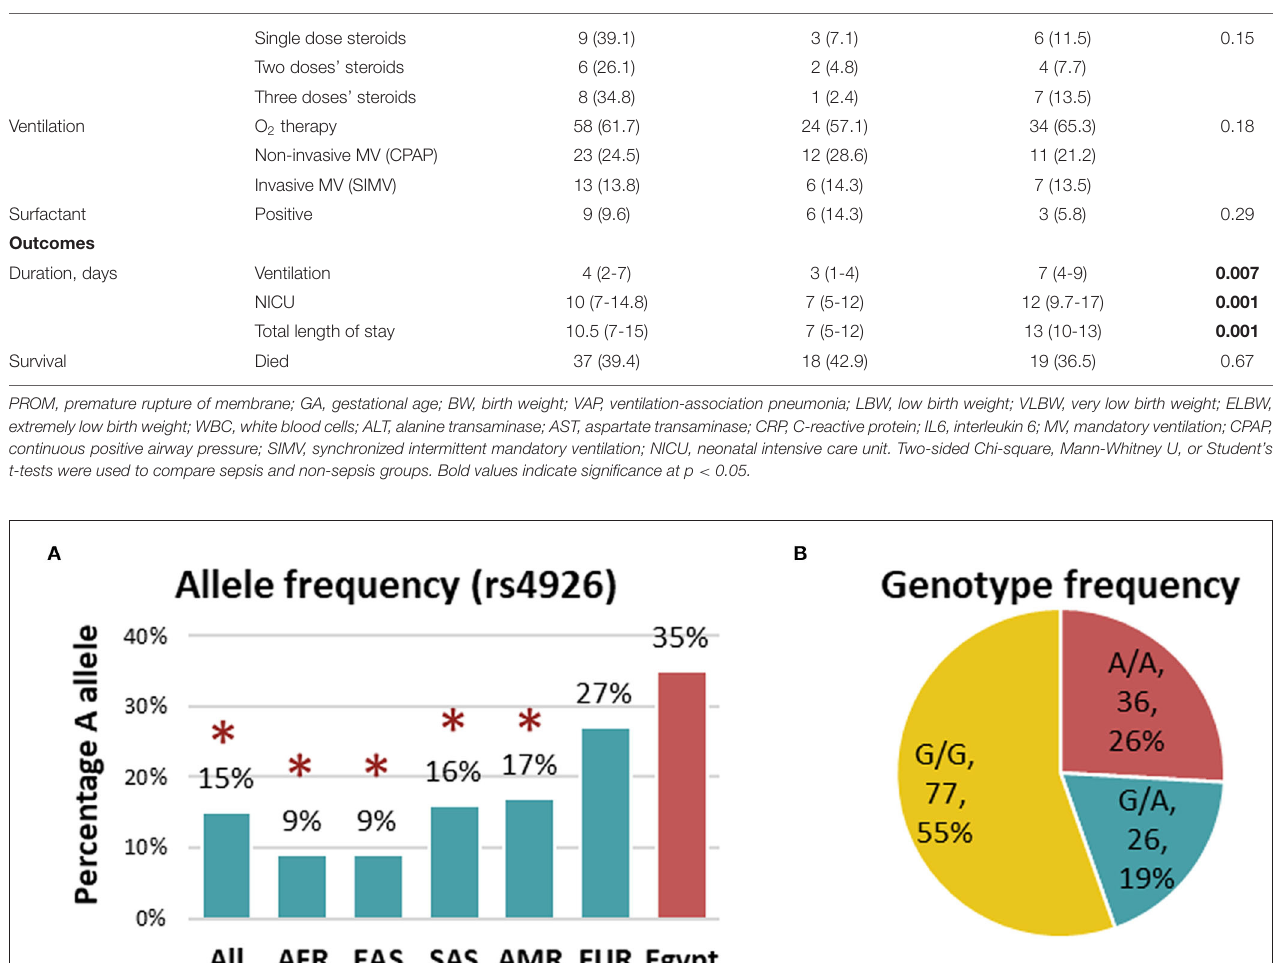
controls (30.9 vs. 15.6%, p = 0.039). Homozygote carriers